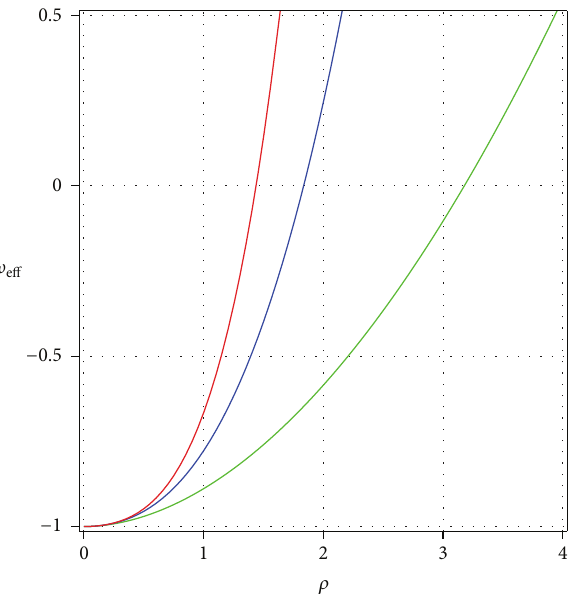
Figure 11: Effective EoS parameter versus density for 𝐵 = 3 , 𝛼 = 0.9 , and 𝐴 = 1/3 . 𝑛 = 1 (green line), 𝑛 = 2 (blue line), 𝑛 = 3 (red